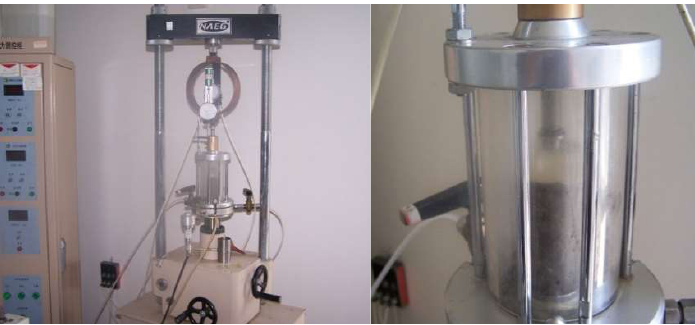
Figure 3. Unconfined compressive strength test by triaxial shear tester.